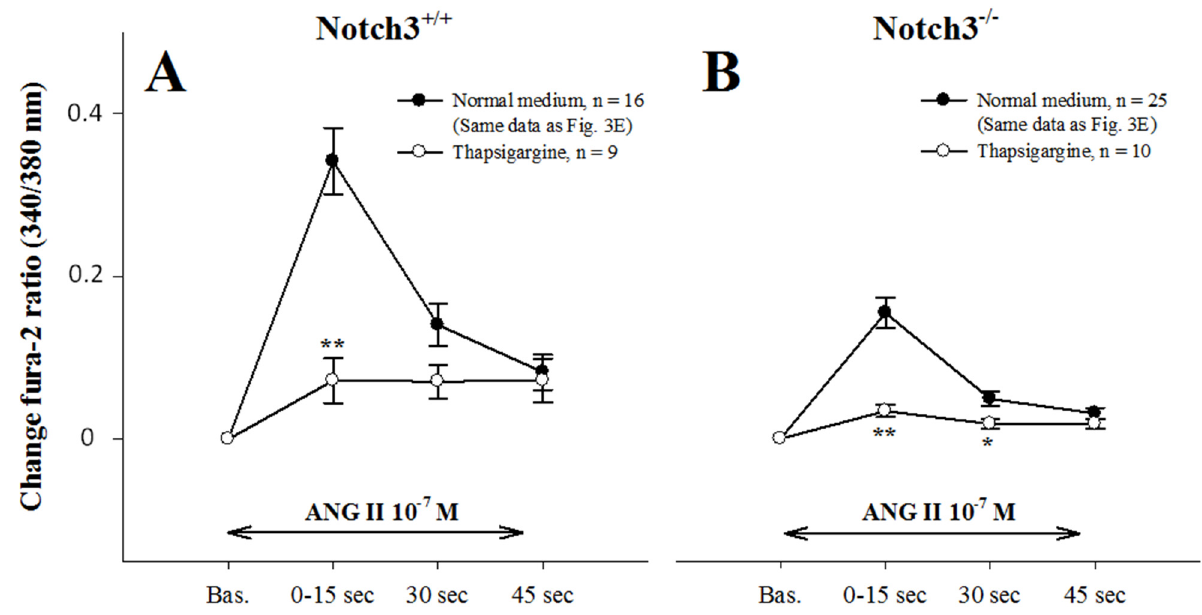
Figure 4. Ca 2+ responses to 10 − 7 M ANG II, before and after administration of the Ca 2+ ATPase inhibitor thapsigargin in wild-type ( A ) and Notch3 − / − ( B ) vessels. Thapsigargin prevented Ca 2+ mobilization from intracellular stores and reduced the peak Ca 2+ response in both strains. * and ** p < 0.05 and p < 0.001, respectively, vs. corresponding response in normal medium.